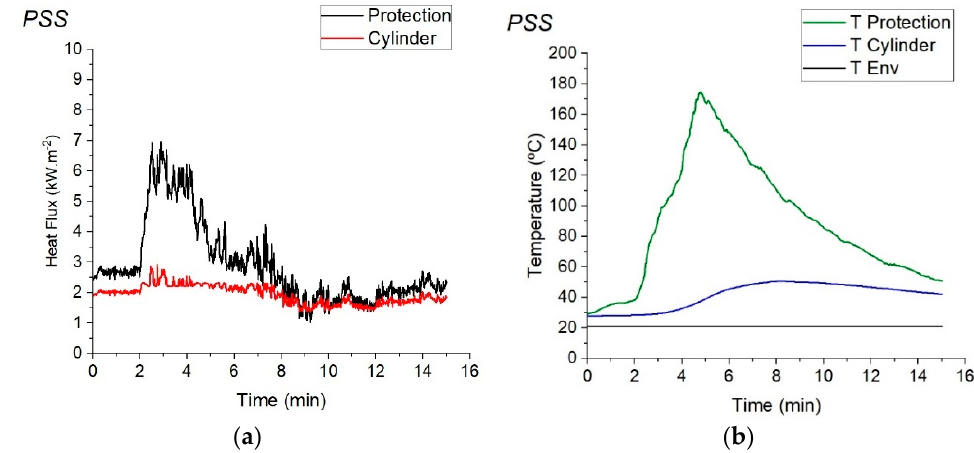
Figure 7. Field test (PSS)—( a ) Heat flux and ( b ) temperature on the surfaces of the protection and cylinder.